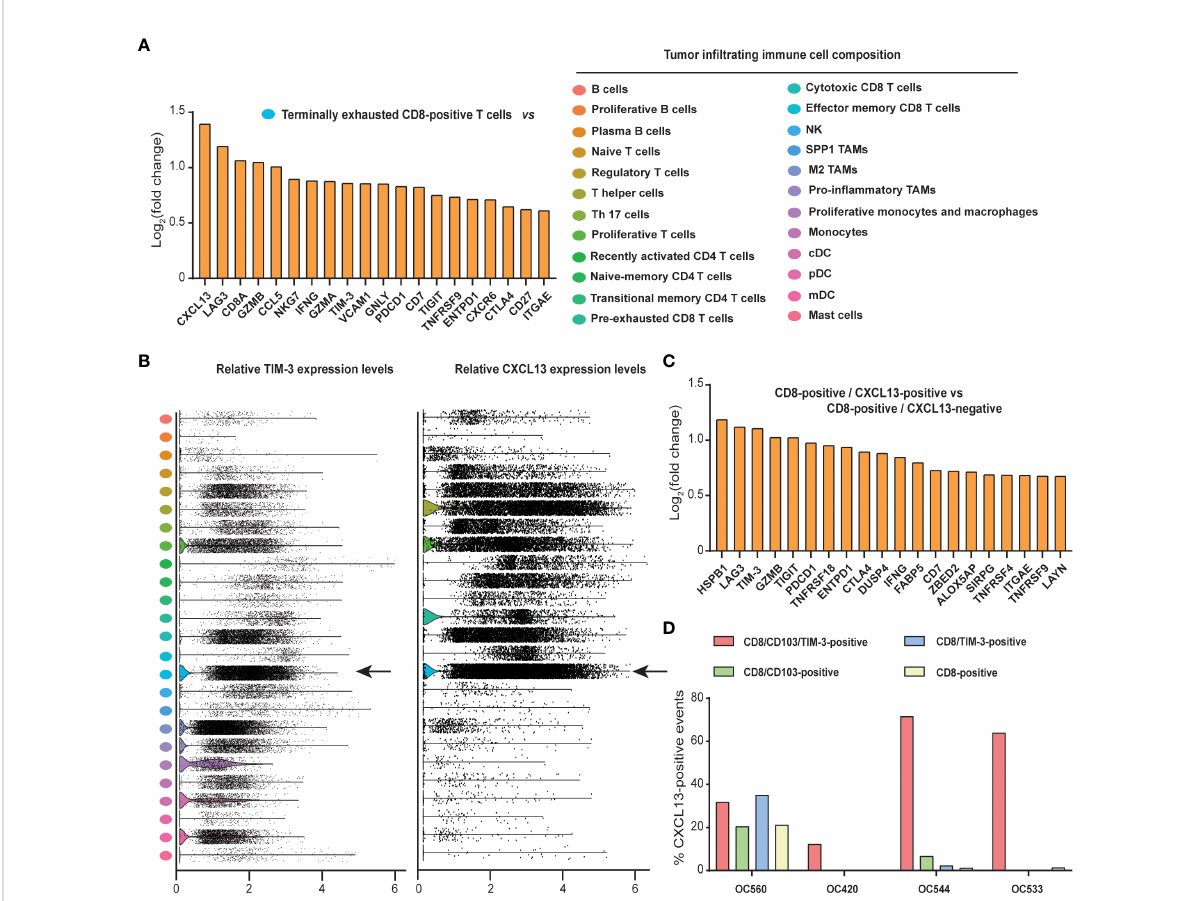
FIGURE 4 Tumor in fi ltrating terminally exhausted CD8-positive T cells have tumor-reactive signatures and co-express CXCL13 and TIM-3. Single-cell tumor immune atlas RNA sequencing data-set based on over 500,000 cells from 217 patients and 13 cancer types to evaluate gene expression in the tumor immune microenvironment. Immune cell fractions were pre-separated into 25 different clusters using canonical markers and curated gene signatures ( A , right). Evaluation of DEGs within the terminally exhausted CD8-positive TIL cluster versus all the other tumor in fi ltrating immune cell clusters ( A , left). Relative TIM-3 and CXCL13 expression found across the different immune cell fractions (B) . DEGs found within the CD8-positive CXCL13-positive vs CD8-positive CXCL13-negative analysis (C) . (D) % CXCL13 events found in CD8/CD103/TIM-3- positive (red bars), CD8/CD103-positive (green bars), CD8/TIM-3-positive (blue bars) and CD8-positive (yellow bars) populations from 4 different primary ovarian cancer patient TIL samples evaluated by fl ow